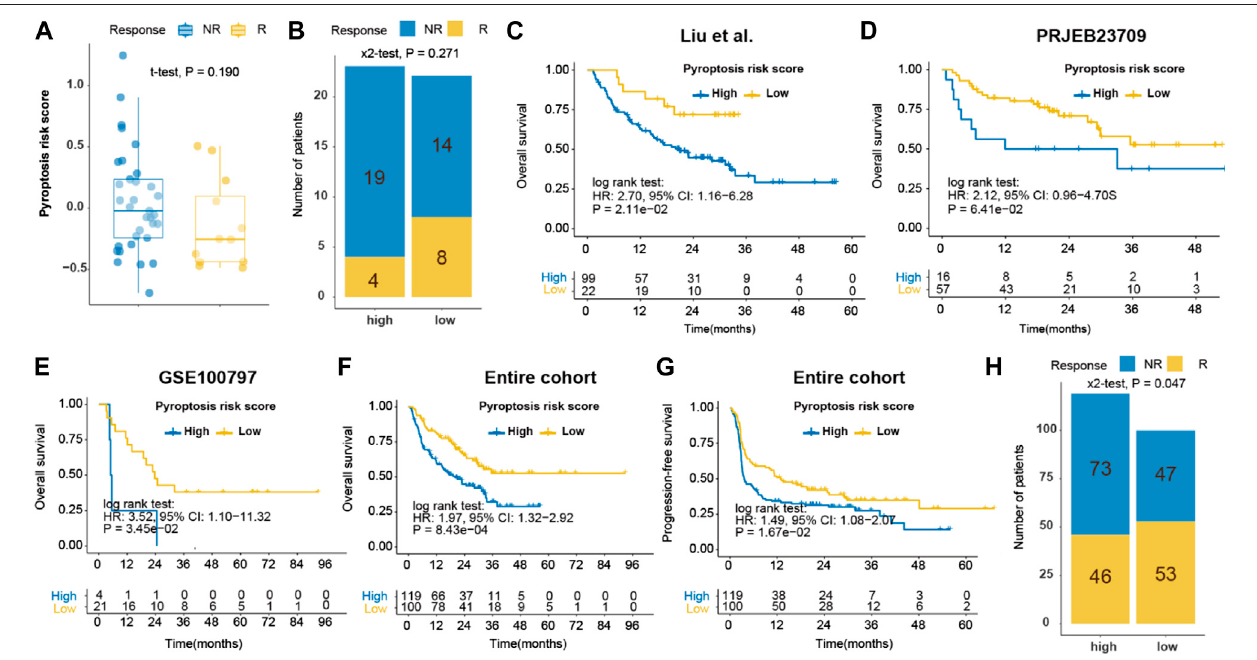
FIGURE10| Predictionofimmuneresponsebypyroptosis riskscore inICB cohorts. (A) Dot plotofpyroptosis risk scorefor responder and non-responder toICB in the Kim cohort (gastric cancer); (B) Bar plot of pyroptosis risk score and response to ICB in the Kim cohort; Kaplan-Meier curves of OS of patients with high- or low- pyroptosis risk score after ICB in the Liu (C) , PRJEB23709 (D) , GSE100797 (E) and entire (F) melanoma cohorts. (G) Kaplan-Meier curves of PFS of patients with low- and high-pyroptosis risk score after ICB in the entire melanoma cohorts. (H) Bar plot of pyroptosis risk score and response to ICB in the entire melanoma cohort. ICB, immune checkpoint blockade. OS, overall survival. PFS, progression-free